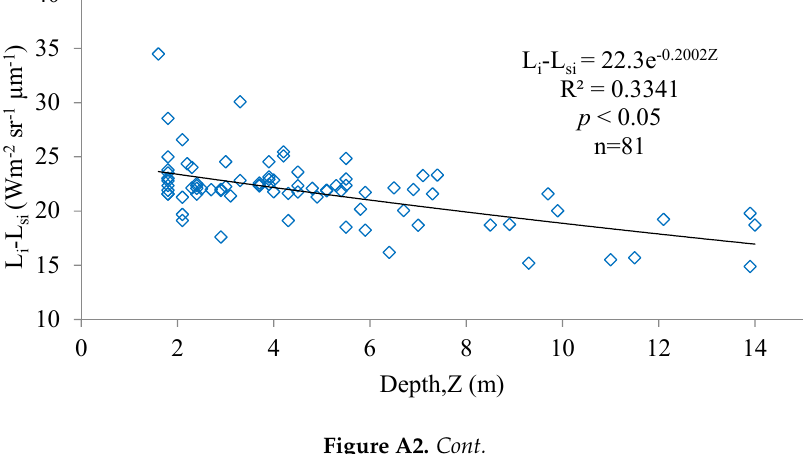
Figure A2. Cont. Figure A2.